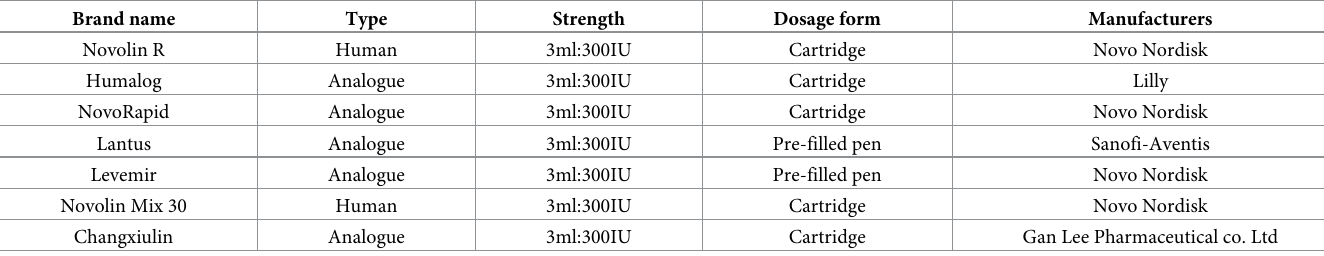
Table 2. The insulin products for the survey of price